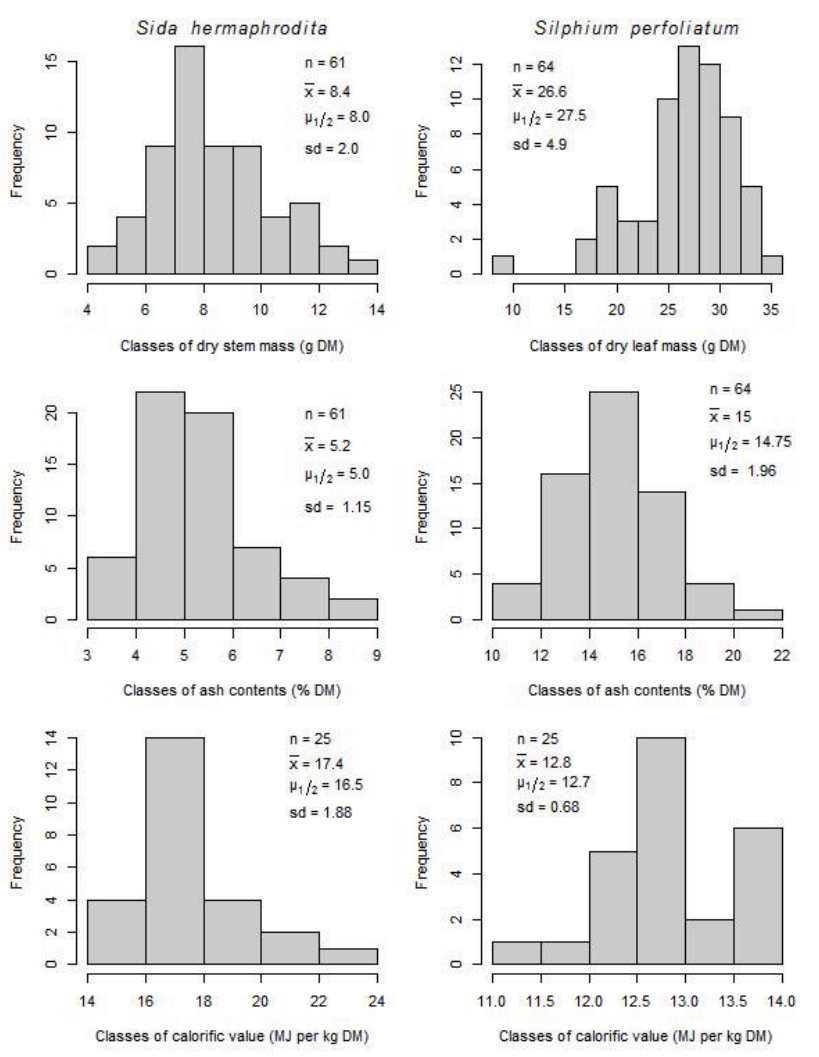
Fig. 4: Histograms of shoot mass, ash contents and calorific values of pot-grown plants of Sida hermaphrodita (left, accession Nr. 3) and S. perfoliatum (right, accession Nr. 8) harvested 263 and 279 DAS, respectively. Note: shoot mass consisted only of stems in S. hermaphrodita and only of leaves in S. perfoliatum .